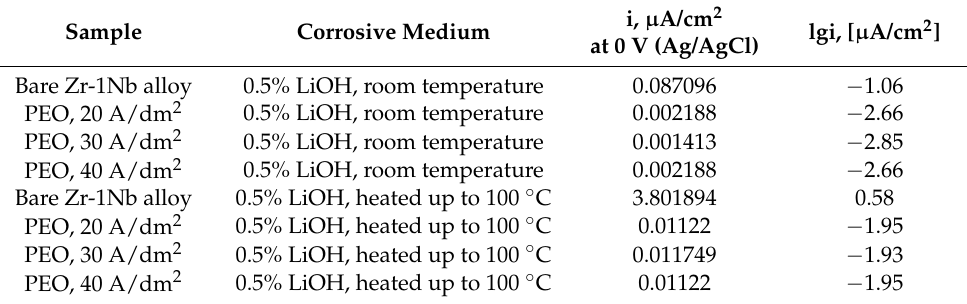
Table 3. Results of potentiodynamic polarization measurements; i—anode current density at potential 0 mV